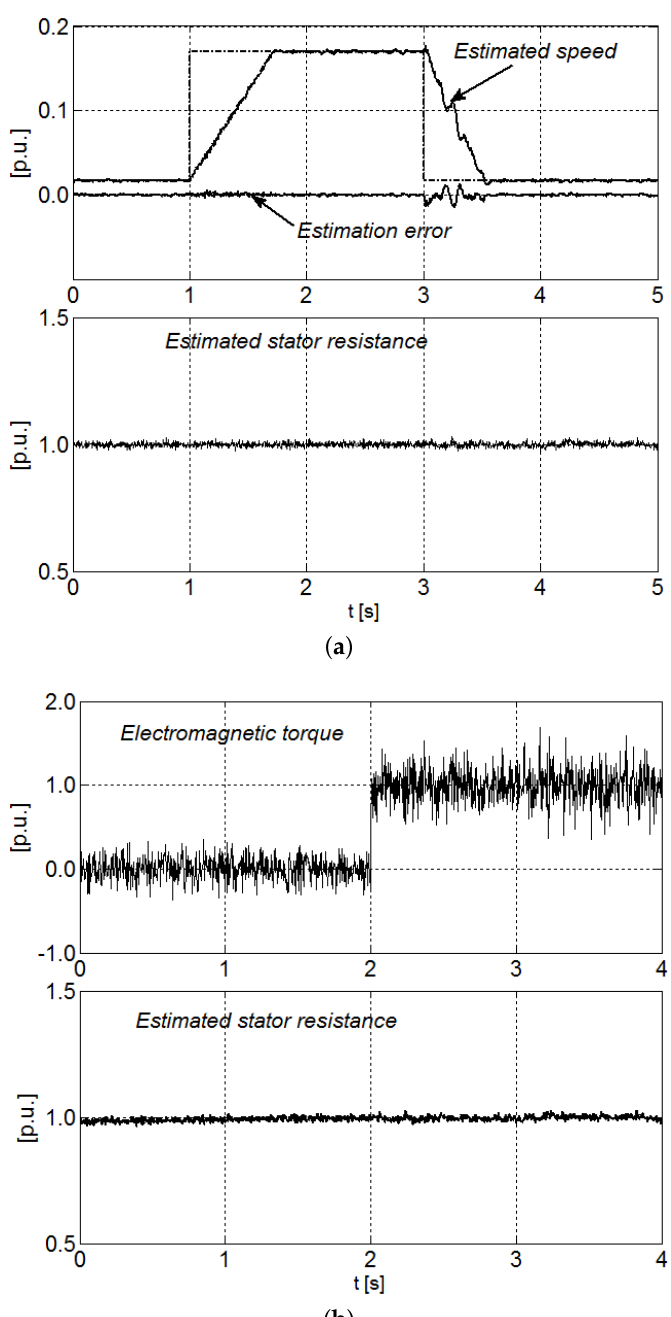
Figure 7. Experimental results of the estimated stator resistance under ( a ) speed changes ( b ) load torque